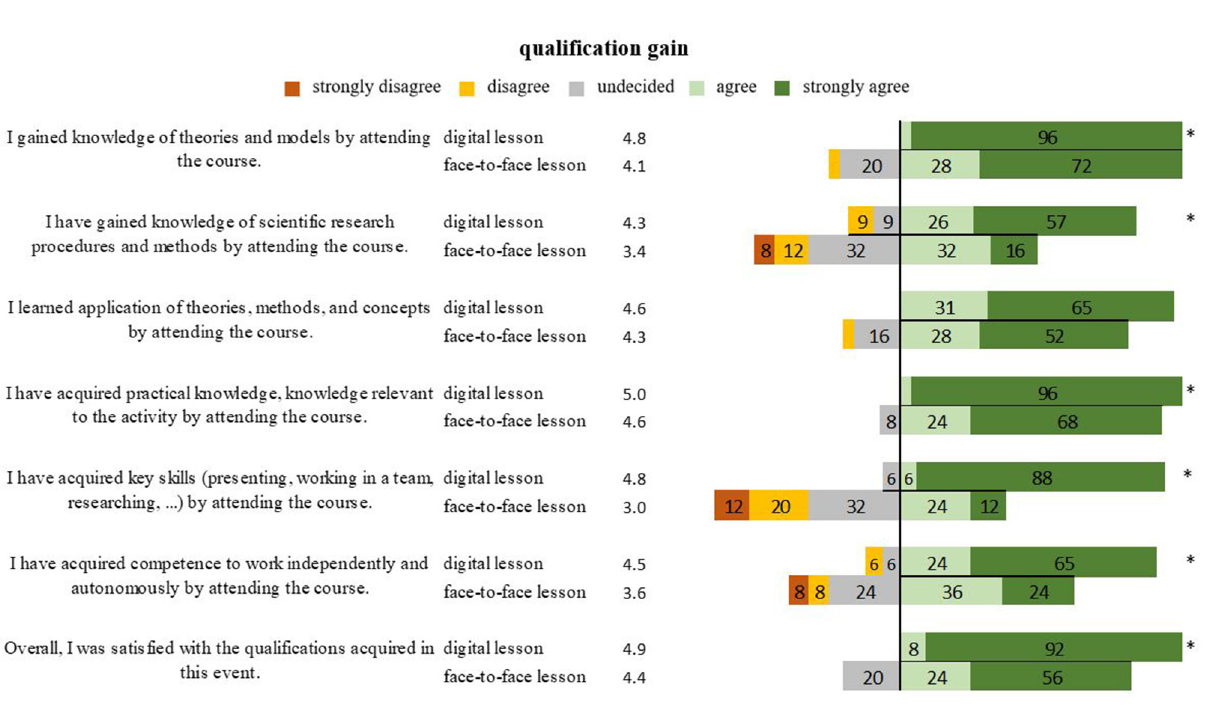
FIGURE4 Representation of students’ opinions on the skills and knowledge acquired in digital and face-to-face teaching in percentages. *Marks significant differences.